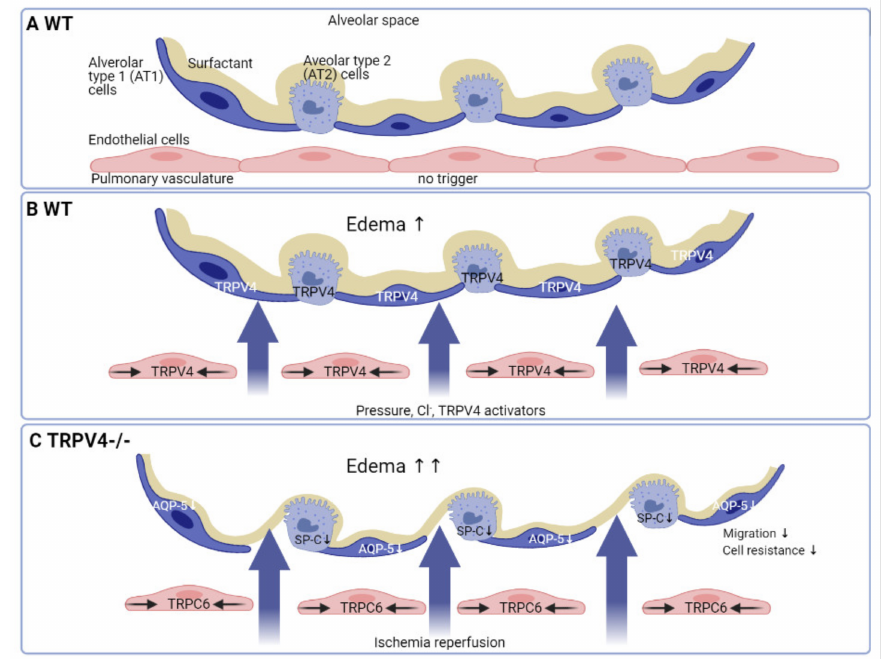
Figure 4. A model for edema formation by different triggers in wild-type (WT) and TRPV4-deficient (TRPV4-/-) lungs. ( A ) The alveolar capillary membrane with resident cells in the quiescent state (no trigger) in wild-type (WT) mice. ( B ) TRPV4 channels are expressed in endothelial, AT1 and AT2 cells. Edema formation by pressure, Cl - and other TRPV4 activators in WT lungs is due to increased endothelial permeability by TRPV4 channels (reviewed in Reference [101]). ( C ) Stronger edema formation by ischemia-reperfusion (IR) in TRPV4-deficient (TRPV4-/-) mice. IR-induced edema is dependent on acute activation of TRPC6 channels in the vascular endothelium and supported by a chronic loss of barrier function in the alveolar epithelium due to ablation of TRPV4 channels. TRPV4 deficiency results in reduced surfactant protein-C (SP-C) production in AT2 and decreased aquaporin-5 (AQP-5) expression in AT1 cells, which also showed less barrier function and reduced cell migration